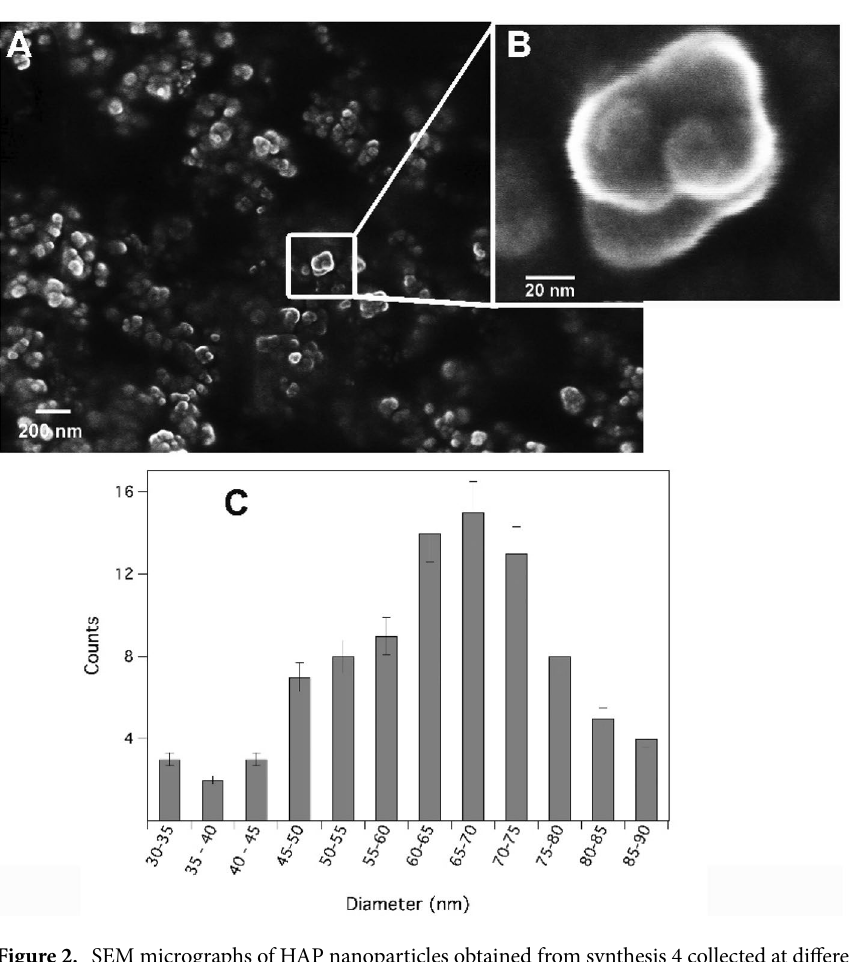
Figure 2. SEM micrographs of HAP nanoparticles obtained from synthesis 4 collected at different magnifications: 10 5 X ( A ) and 10 6 X ( B ); ( C ) size distributions of HAP nanoparticles from synthesis 4 dispersed in 2-propanol obtained by the SEM micrographs and elaborated through ImageJ.